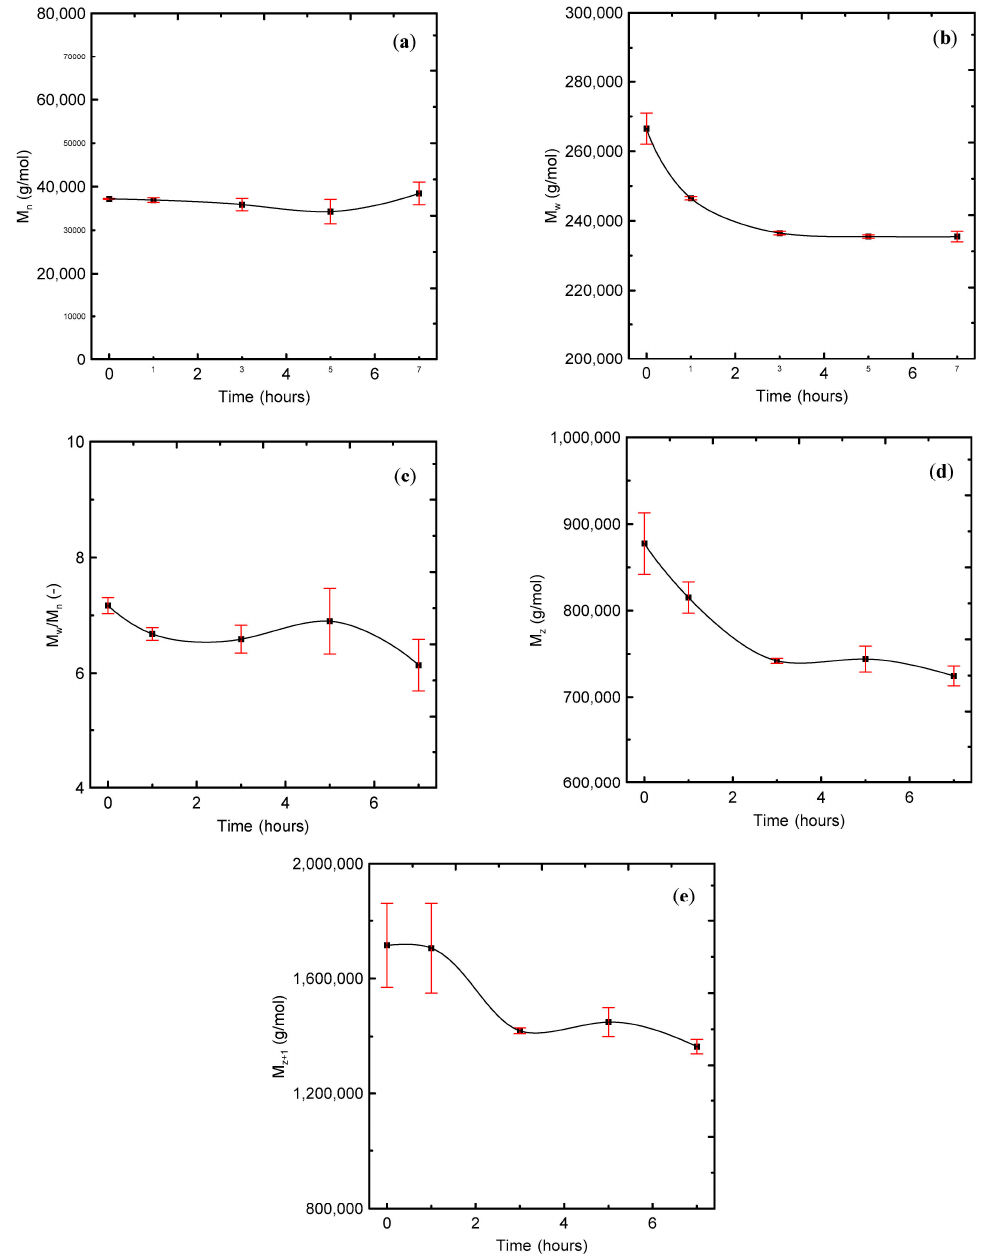
Figure 6. Effect of degradation time on the molecular weight distribution of investigated polypropylene. ( a ) Number average molecular weight ( M n ); ( b ) Weight average molecular weight ( M w ); ( c ) Polydisperzity index ( M w / M n ) ; ( d ) M z average molecular weight; ( e ) M z +1 average molecular weight. Transient extensional viscosity data for virgin as well as thermally degraded branched PPs evaluated at different extensional strain rates (in the range 0.001–14.3 s − 1 ) are provided in Figure 7. Here LVE represents Linear Viscoelastic Envelope determined from discontinuous relaxation spectrum. The “steady-state” uniaxial extensional viscosity data were determined from the peaks appearing on the transient viscosity curves for corresponding extensional strain rates. Obtained “steady-state” extensional viscosity data, normalized by the 3 times Newtonian viscosity (measure